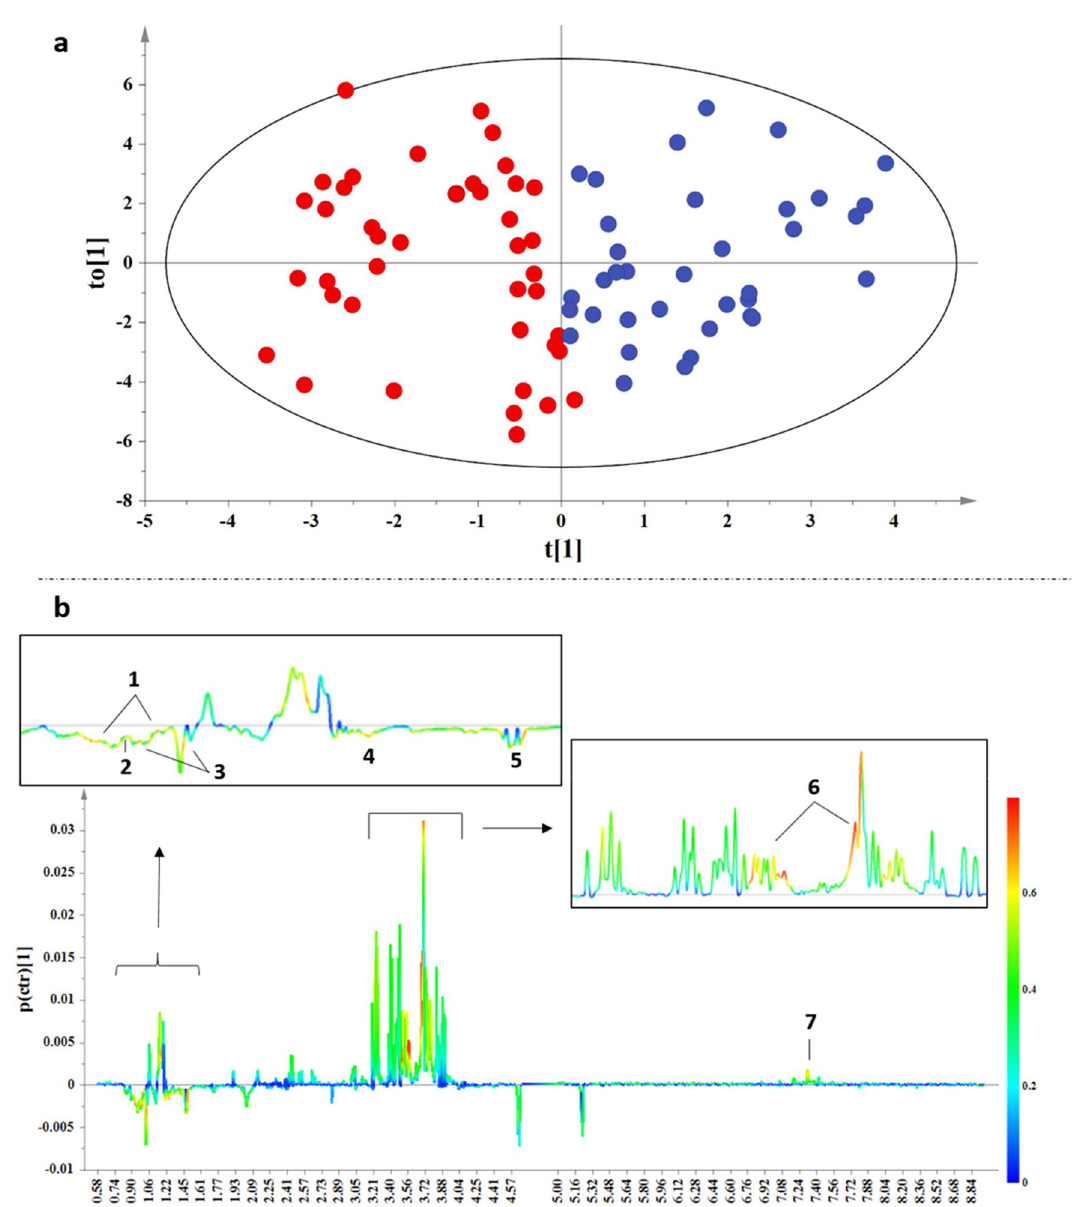
R 2 Y(cum) = 0.65, Q 2 (cum) = 0.566 for pareto scaling and 95% confidence level. IUGR are represented with red circles and AGA correspond to blue circles. ( b ) Loadings plot demonstrate the metabolites responsible for discrimination, 1: Isoleucine, 2: Leucine, 3: Valine, 4: 3-Hydroxybutyrate, 5: Alanine, 6: Glycerol, 7: